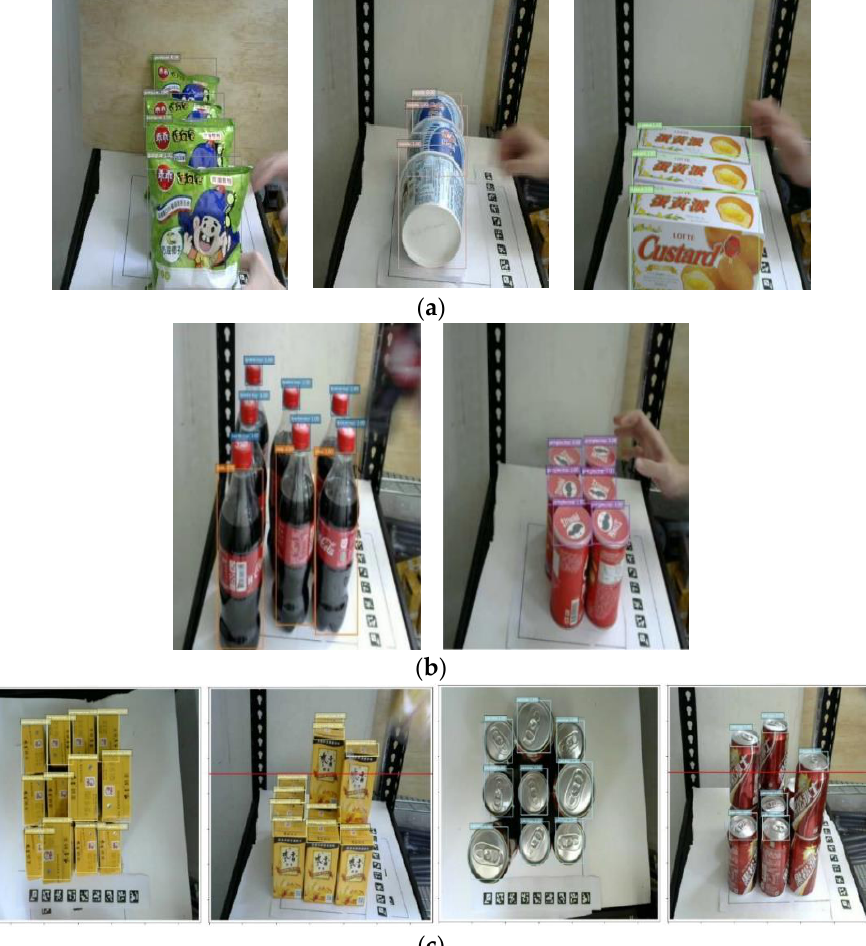
Figure 10. Identifying products in different categories. ( a ) Packed products; ( b ) top view for dense